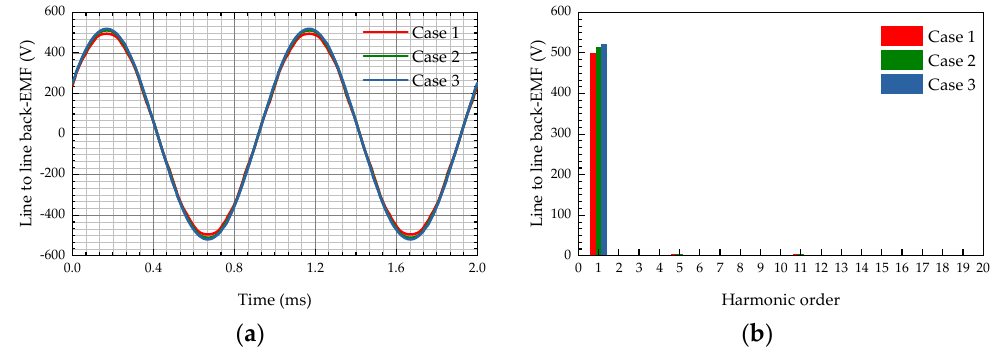
Figure 12. The line to line back ‐ EMF and its Fourier transforms under the three cases at no load: ( a ) line to line back ‐ EMF waveform; ( b ) Fourier transform results.